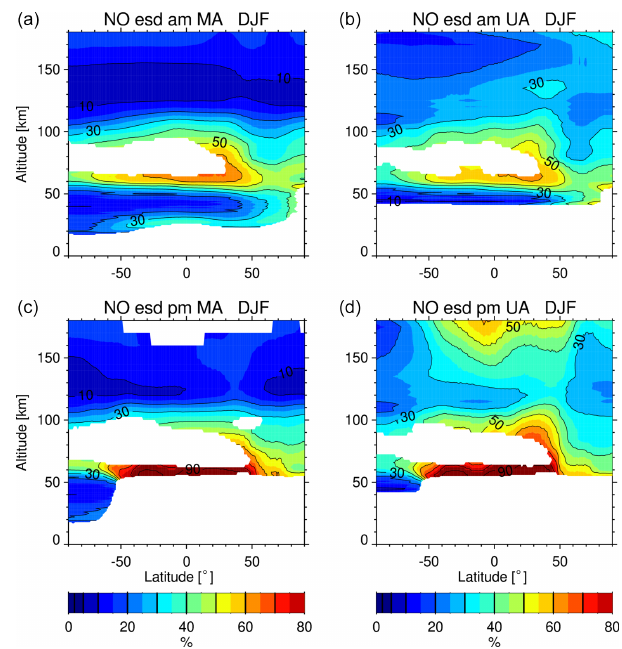
Figure 7. The estimated standard deviation (esd) of the measure- ment noise component of the NO retrieval error during the northern winter season (December–January, DJF) for (a, c) MA and (b, d) UA measurements as a function of latitude and altitude, separated for (a, b) morning and (c, d) afternoon. White areas indicate data with insignificant information content (AK diagonal <